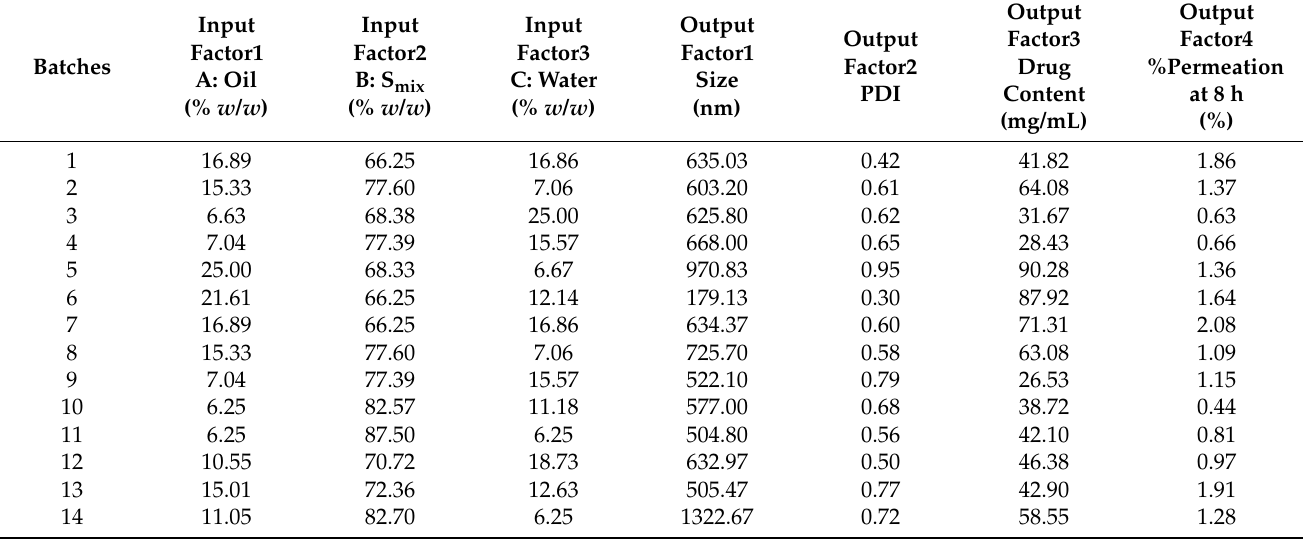
Table 1. Experimental batches of FLUZ-loaded MEs and output factors using I-optimal design.